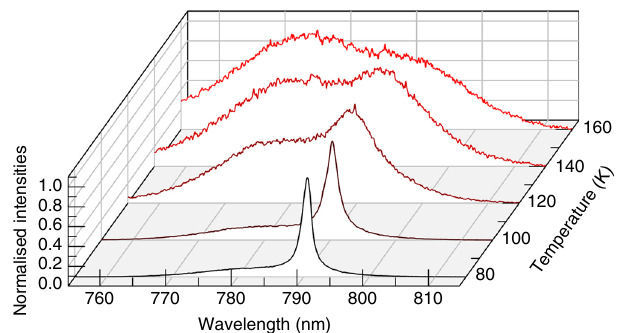
Fig. 5 ASE spectra under CW excitation at various temperatures and constant pump intensity. The amount of photons emitted into the ASE mode decreases with increasing temperature until ~120 K, after which spontaneous emission dominates. The excitation power was kept constant at 1512 W cm − (and above), a further increase of the pump intensity could not recover the ASE peak, but rather led to a fast degradation of the PL intensity. This indicates that at higher temperatures the material degrades before the CW ASE threshold is reached.